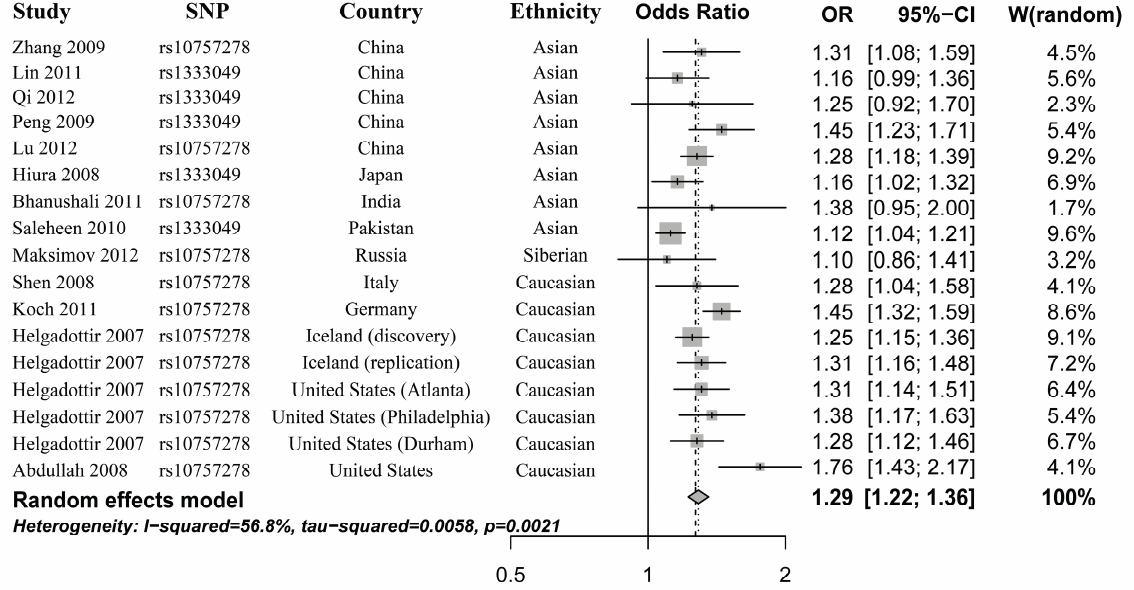
Figure 2. Forest plot for the meta-analysis of rs10757278 polymorphism using an additive model. The risk alleles are G for rs10757278 polymorphism and C for rs1333049